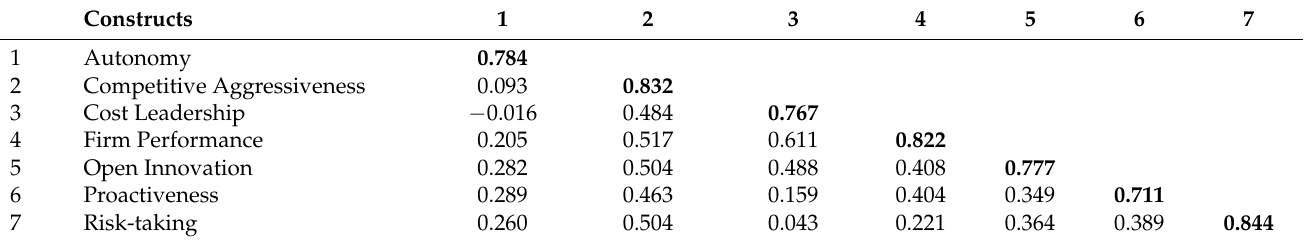
Table 4. Discriminant Validity